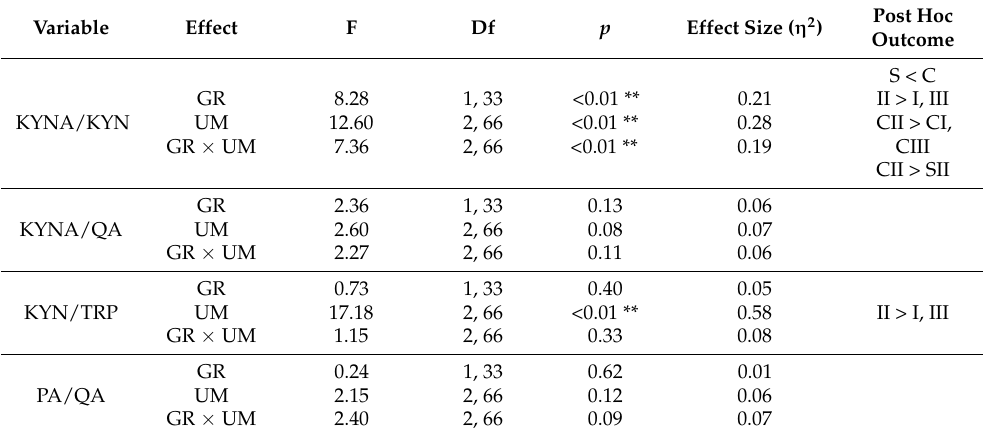
Table 3. Two-way ANOVA (2 groups × 3 repeated measures) of changes in KYN metabolite and TRP ratios induced by ultramarathon run.